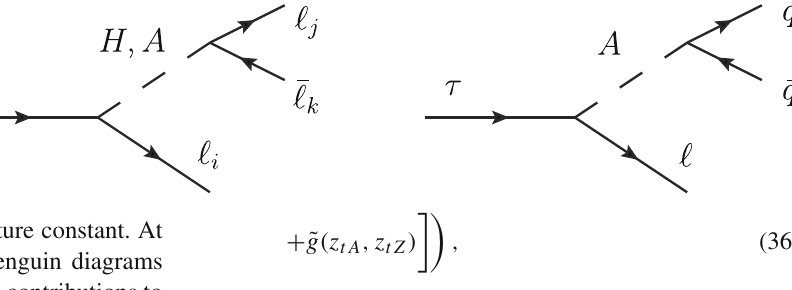
where α em ≡ e 2 / 4 π is the QED fine structure constant. At one loop, such decay proceeds through penguin